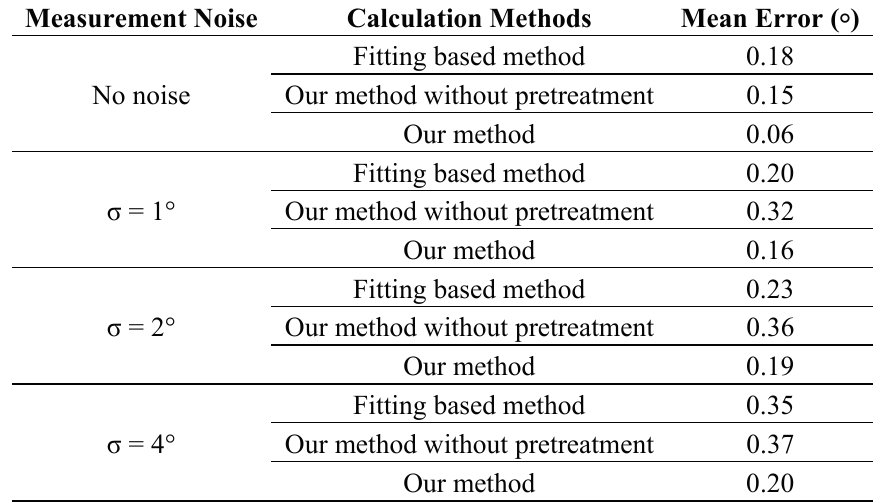
Figure 4. The solar meridian orientations extracted by ( a ) fitting based method; ( b ) our method without pretreatment and ( c ) our method when the standard variance of noise σ is 4 degrees. Table 2. The error of the solar meridian orientation extracted by the three